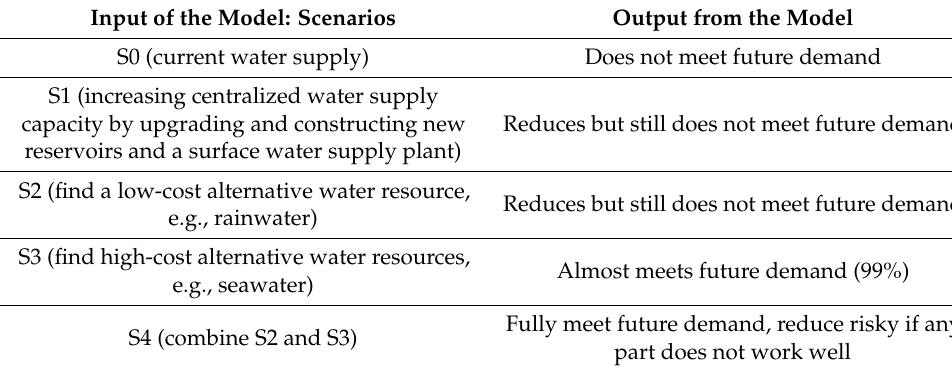
Table 3. Input socio-economic scenarios and output from the